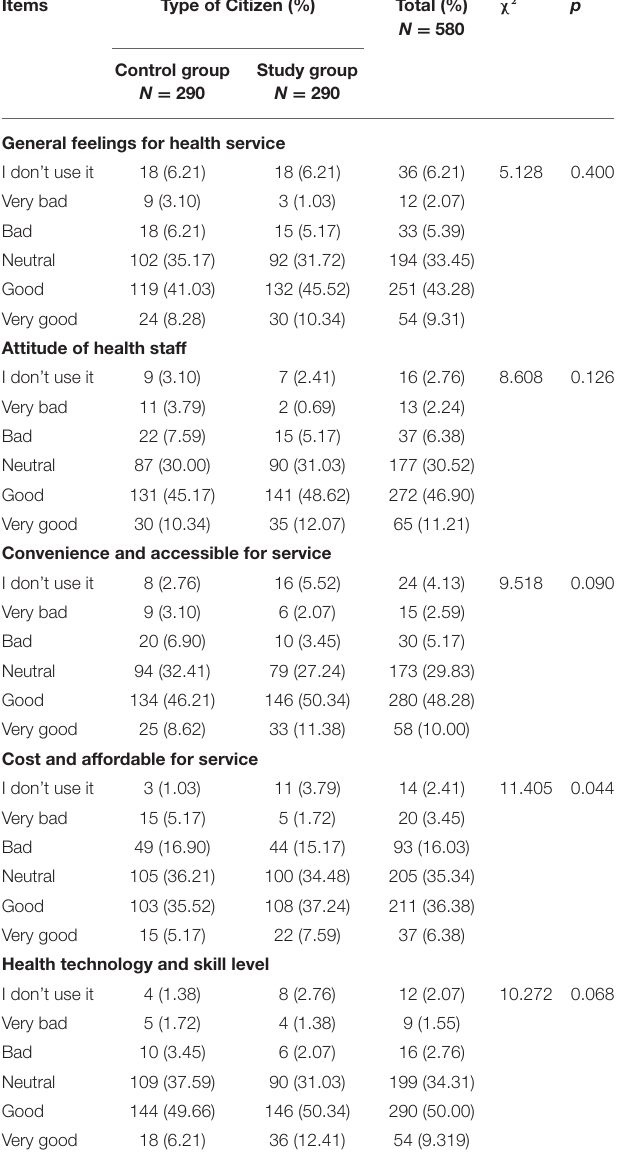
TABLE 2 | Satisfactions evaluation for health service among all interviewees and two